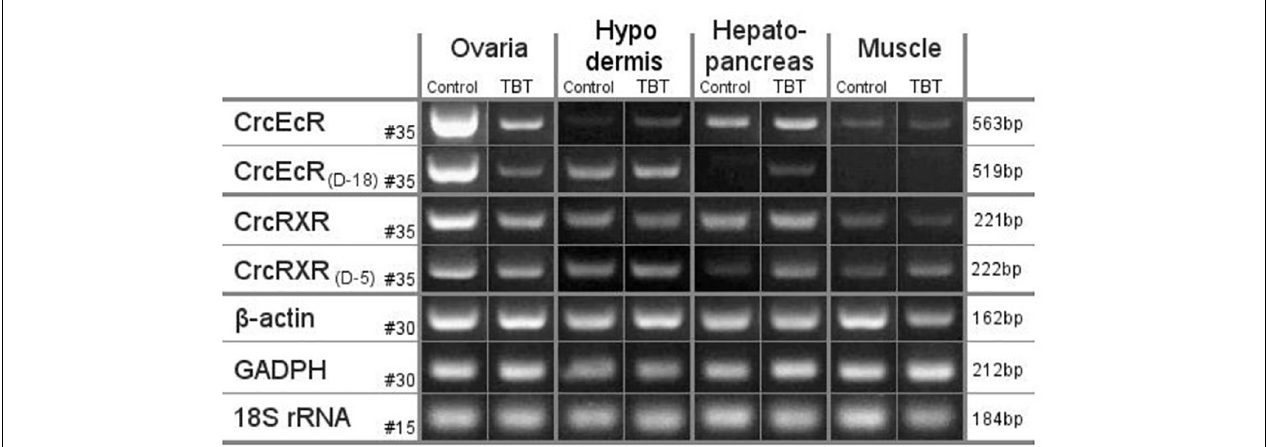
FIGURE 6 | mRNA levels in ovaries, hypodermis, hepatopancreas and muscle of C. crangon after exposure to TBT. Semiquantitative RT-PCR results of C. crangon exposed to 134 nM TBT for 96 h compared with mRNA expression in the control group for the non-truncated CrcEcR and CrcRXR isoforms. mRNA levels of the control genes b-actin, glyceraldehyde-3-phosphate (GADPH) and 18S rRNA are also represented. Amplified gene names and cycle number are given on the left, template tissue and experimental group are given at the top, amplicon size is given at the right. Truncated CrcEcR and CrcRXR isoforms are not shown as they were only detected in the ovaries at higher PCR cycle numbers. CrcEcRD-18 bands were clearly visible for hepatopancreas tissue of the control group and muscle tissue at 40 PCR cycles but not at 35 cycles (Verhaegen et al., 2011; Verhaegen,